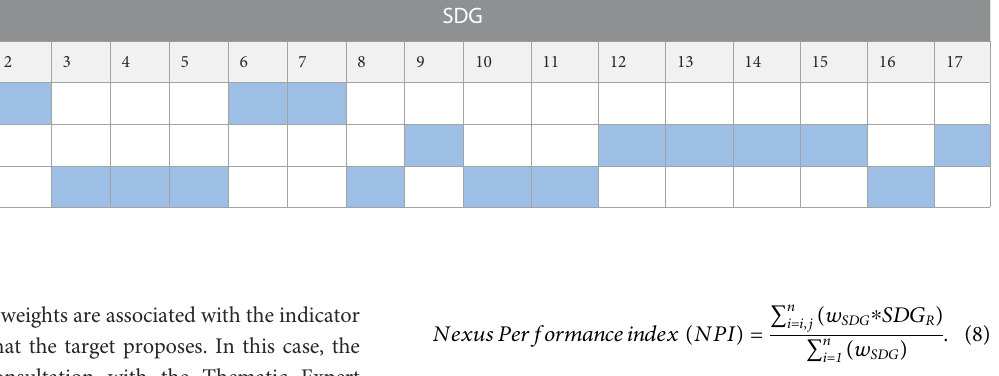
TABLE 1 Weights assigned to each SDG 2 in the performance Nexus index. Weights